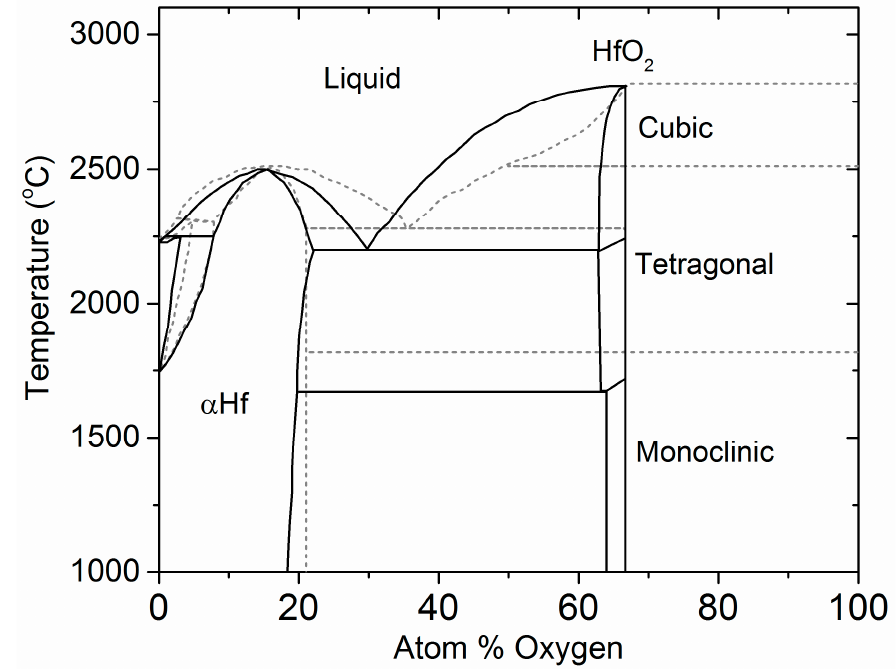
Figure 6. Assessment of the Hf–O phase diagram (solid line) [46] and DFT-based CALPHAD calculation of the Hf–O diagram (dashed line) [47].